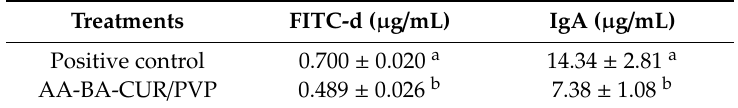
Therapeutic administration of a 0.1% mixture containing ascorbic acid (AA) and a solid dispersion of curcumin with polyvinylpyrrolidone (CUR / PVP, ratio 1:9) and boric acid (BA) (AA-CUR / PVP-BA), on serum concentration of fluorescein isothiocyanate-dextran (FITC-d), and total intestinal immunoglobulin A (IgA) levels in broiler chickens on day ten post Salmonella Enteritidis ( S . Enteritidis) challenge 1 (experiment 2). Treatments FITC-d ( µ g / mL) IgA ( µ g / mL) 7.38 ± 1.08